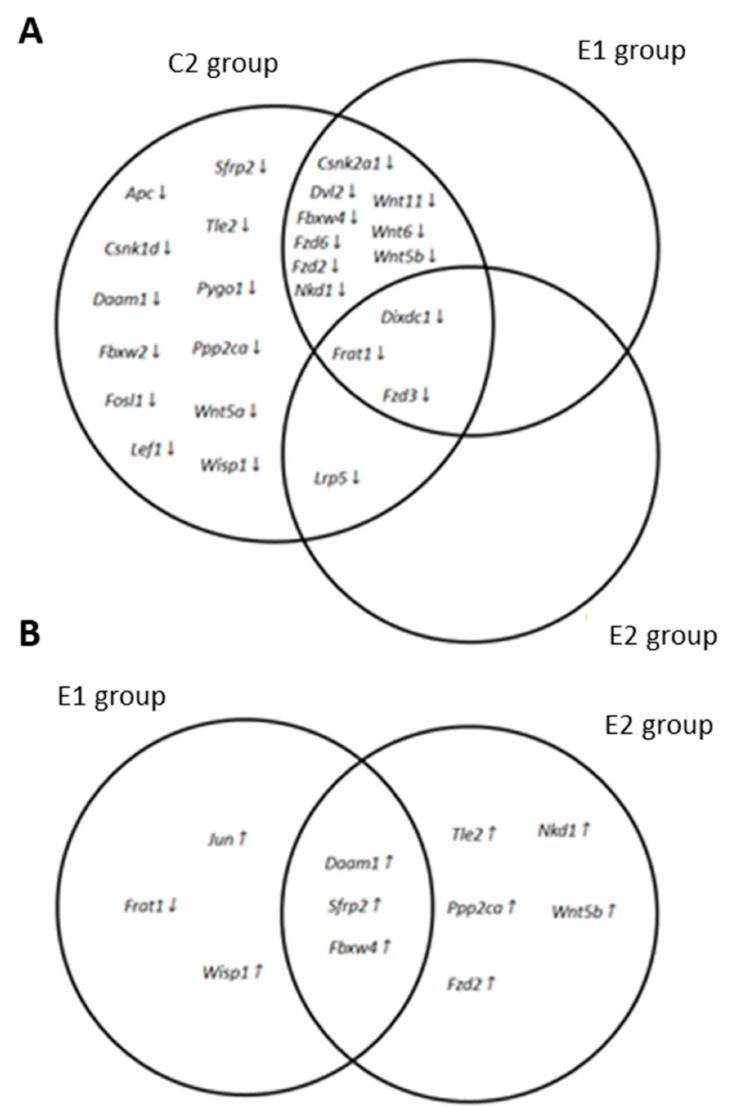
Figure 6. An overlapping pattern of genes of the Wnt signaling pathway modified in APC Min/+ mice fed with standard and supplemented diets. Edwards-Venn diagrams showing the genes overexpressed at least 2 times (up arrows) or downregulated by 50% (down arrows) in APC Min/+ mice fed with a standard diet (C2 group), fed with a ( Bf + Lg ) supplemented diet (E1 group), or fed with a ( Bf + Lg +Q) supplemented diet (E2 group). ( A ) Genes modified in APC Min/+ mice as compared to wild-type mice. ( B ) Genes modified in APC Min/+ E1 and E2 groups fed with supplemented diets as compared to the APC Min/+ control group